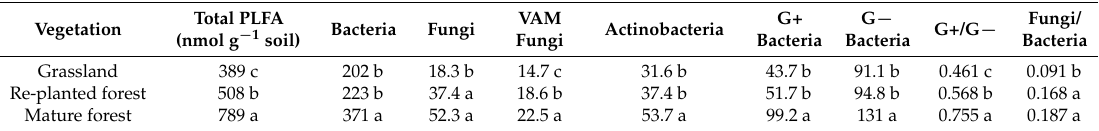
Table 3. Content of phospholipid acid biomarkers of the total microbial community and individual groups in soils under three types of vegetation.